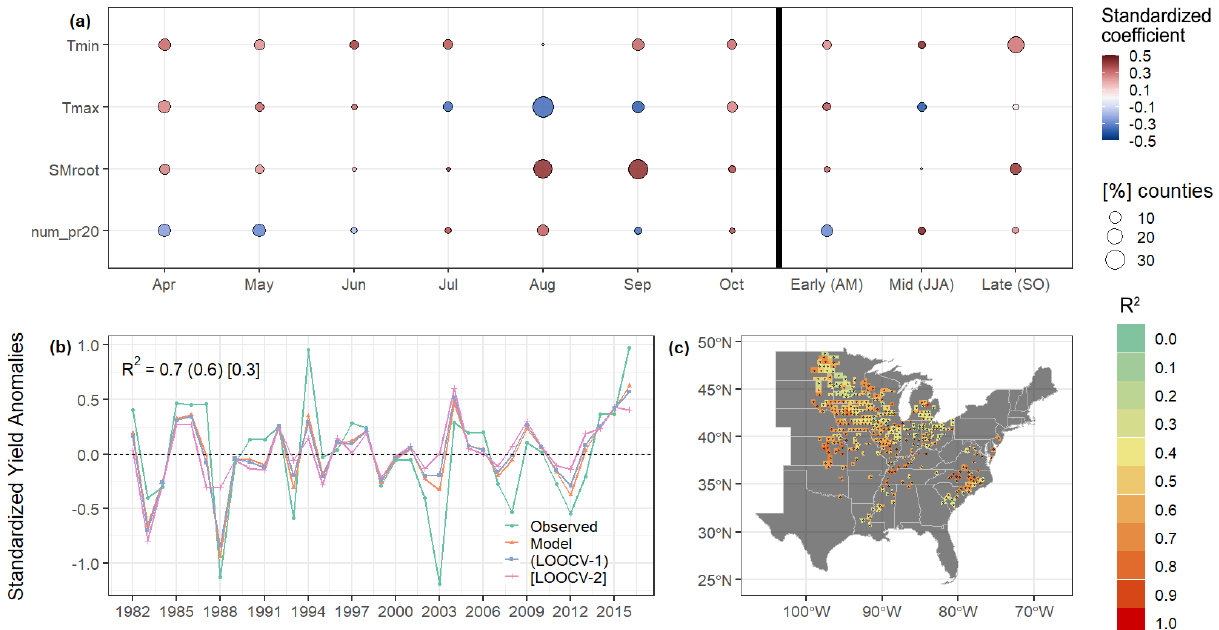
Figure 3. (a) Summary of the strength and frequency of selected predictors across the growing season. (b, c) Explained variance ( R 2 ) of yield anomalies due to climate variability, (b) spatially averaged and (c) at the county scale. The stippling in panel (c) shows F tests, with p < 0 . 05 indicating that the model chosen is significantly better than a null model (accounting for the false discovery rate due to multiple hypotheses